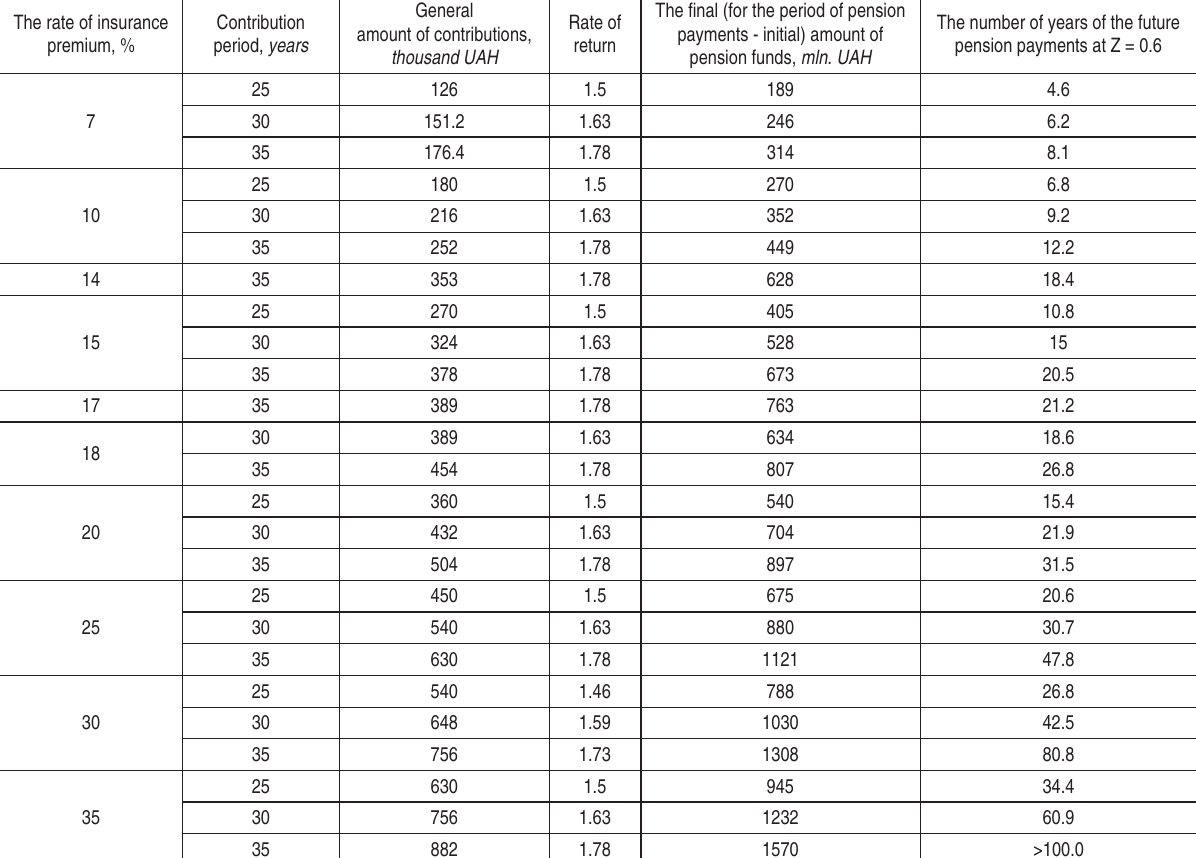
The number of years of the future pension payments at Z =